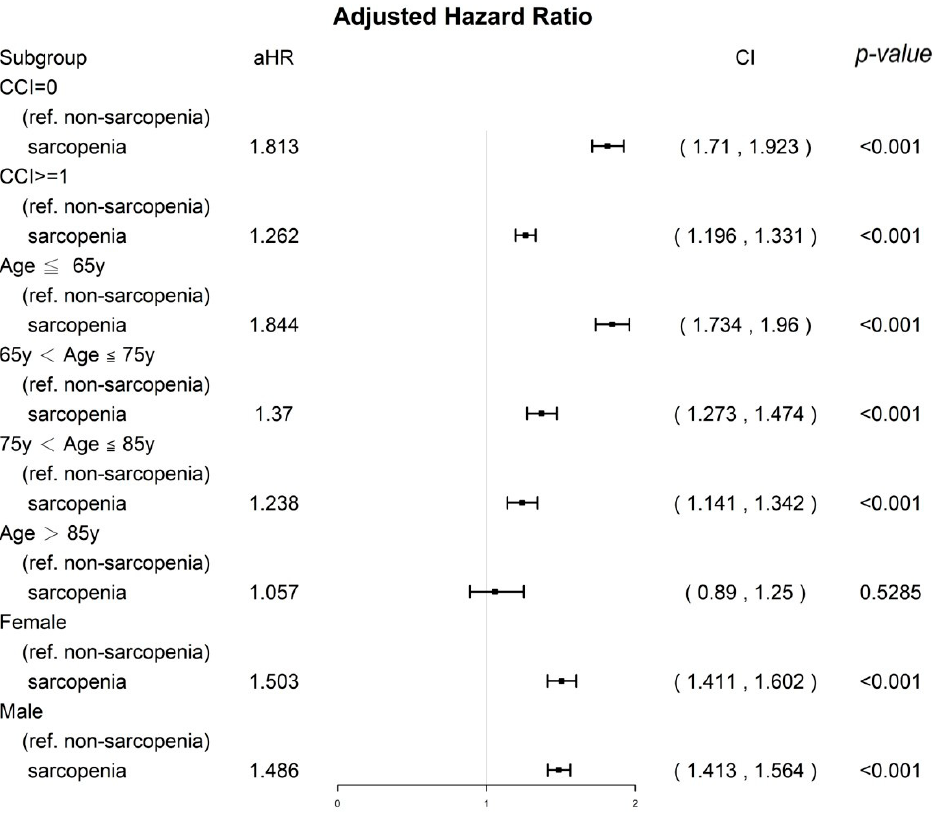
Figure 2. A sensitivity analysis of sex, age groups, and CCI scores by using inverse probability of treatment weighting for all-cause death in the propensity score–matched sarcopenia and nonsarcopenia groups. All covariates presented in Table 2 were adjusted.